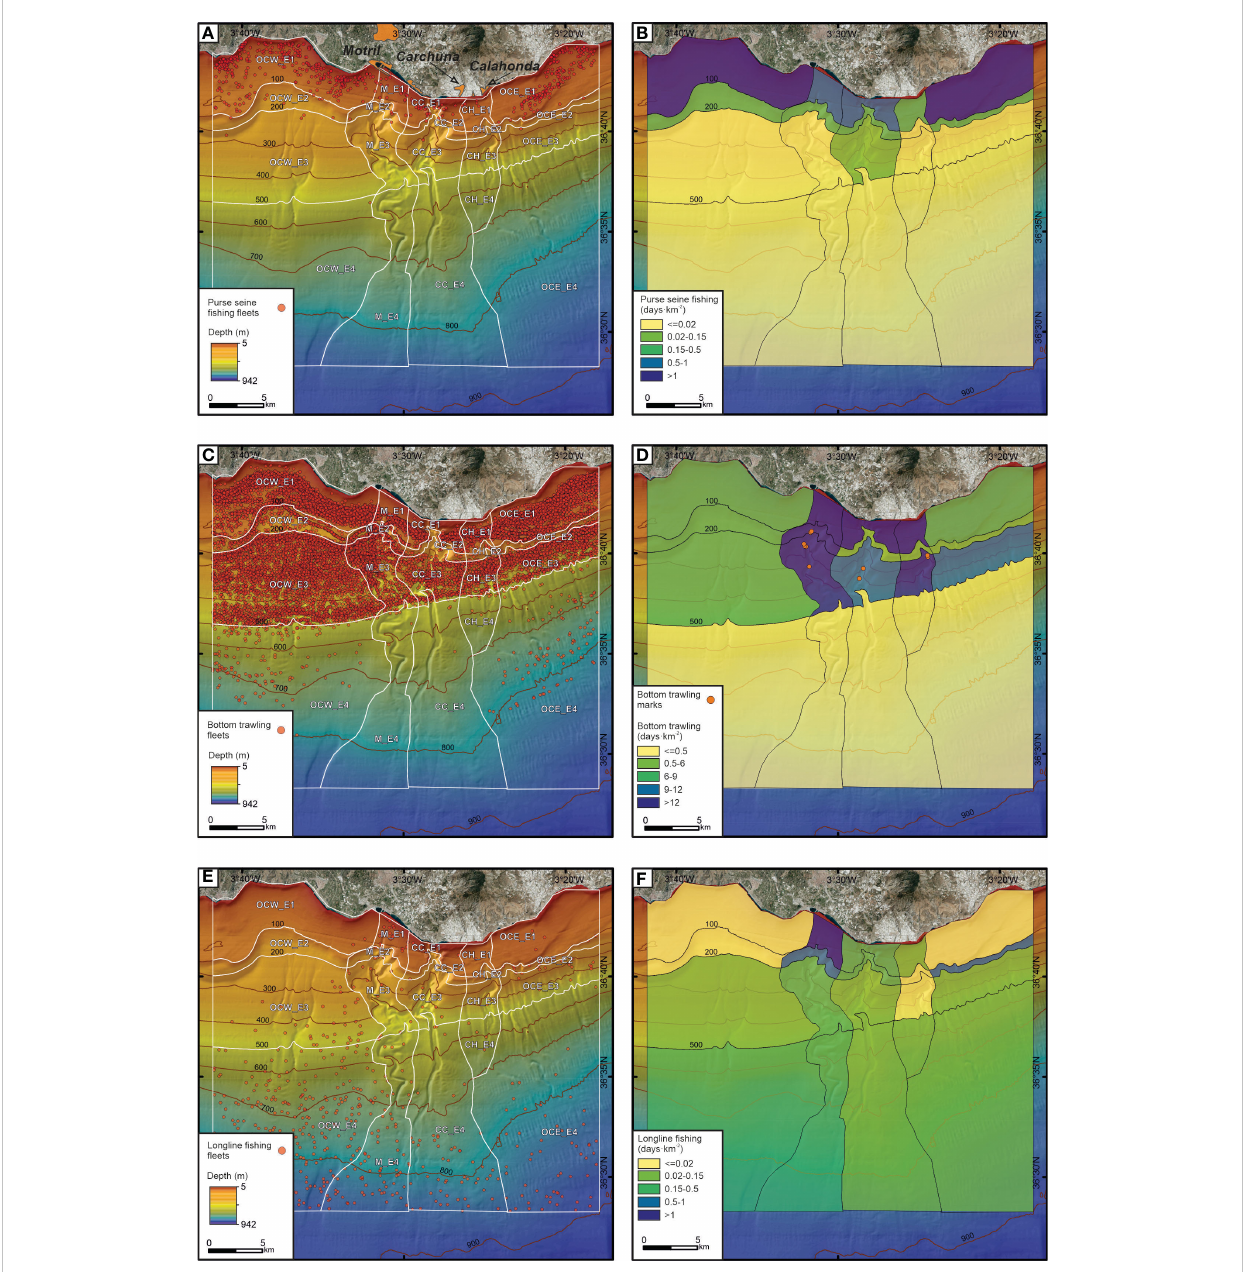
FIGURE 10 Data from Vessel Monitoring System during 2018-2019 ( “ Ministerio de Pesca, Agricultura y Alimentacio ́ n ” , Spanish government). Spatial distribution of purse seine fi shing fl eets (A) , bottom trawling (C) and longline fi shing (E) . Fishing effort (in days·km -2 ) for purse seine fi shing (B) , bottom trawling (D) and longline fi shing (F) . The bottom trawling marks seen on video footage collected by the ROV in the three submarine canyons is shown (D) . See Supplementary Table 2 to location and depth of the bottom trawling marks and Figures 7A, B for examples of sea fl oor trawling marks along the fl ank of Motril Canyon and the thalweg of Calahonda Canyon. OCW, Western sector of the study area; M, Motril Canyon; CC, Carchuna Canyon; CH, Calahonda Canyon; OCE, Eastern sector of the study area; E1: Shelf; E2: Outer shelf-uppermost slope; E3: Upper slope; E4: Middle slope. Bathymetric contours in